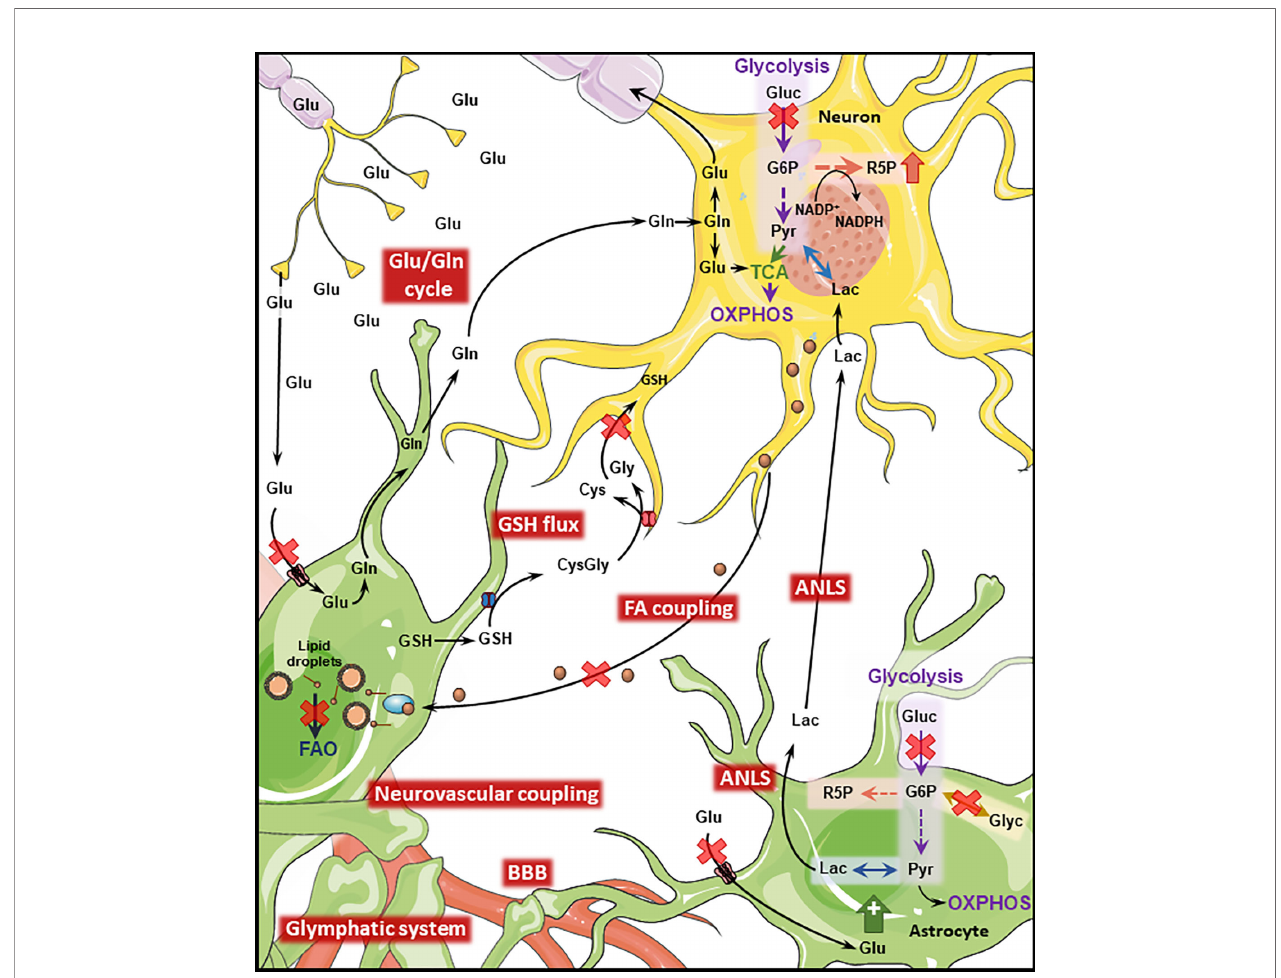
FIGURE 2 | Disrupted Astrocyte-Neuron metabolic interplay in PD and AD. Metabolic interaction between astrocytes and neurons is disrupted in AD and PD. Both diseases present cerebral hypoperfusion with associated degradation of BBB integrity which might impact the function of the glymphatic system. Neurovascular coupling is impaired in AD. Cerebral hypoperfusion is accompanied by reduced glucose metabolism which will transversely affect downstream pathways such as the ANLS. Astrocytic glycogen metabolism is regulated by noradrenaline and insulin being impaired in both diseases. Neuronal PPP is upregulated in AD and late PD as a response to increased oxidative stress. Oxidative stress is further exacerbated by disruption of the GSH fl ux from astrocytes to neurons. The transfer of neuronal peroxidated FA to astrocytes where they are degraded through FAO is impaired by the AD-related ApoE4 isoform, leading to the accumulation of such toxic FA. The Glu/GLn cycle is impaired in both conditions, due to defective removal of glutamate from the synaptic cleft which leads to excitotoxicity-induced neuronal loss. (Gluc, glucose; Glu, glutamate; Gln, glutamine; Lac, lactate; Pyr, pyruvate; Glyc, glycogen; R5P, ribose 5-phosphate; G6P, glucose 6-phosphate; GSH, glutathione; Cys, cysteine; Gly, glycine; FAO, fatty acid oxidation; TCA, tricarboxylic acid cycle). Figure created with images adapted from Servier Medical Art by Servier; licensed under a Creative Common Attribution 3.0 Unported License